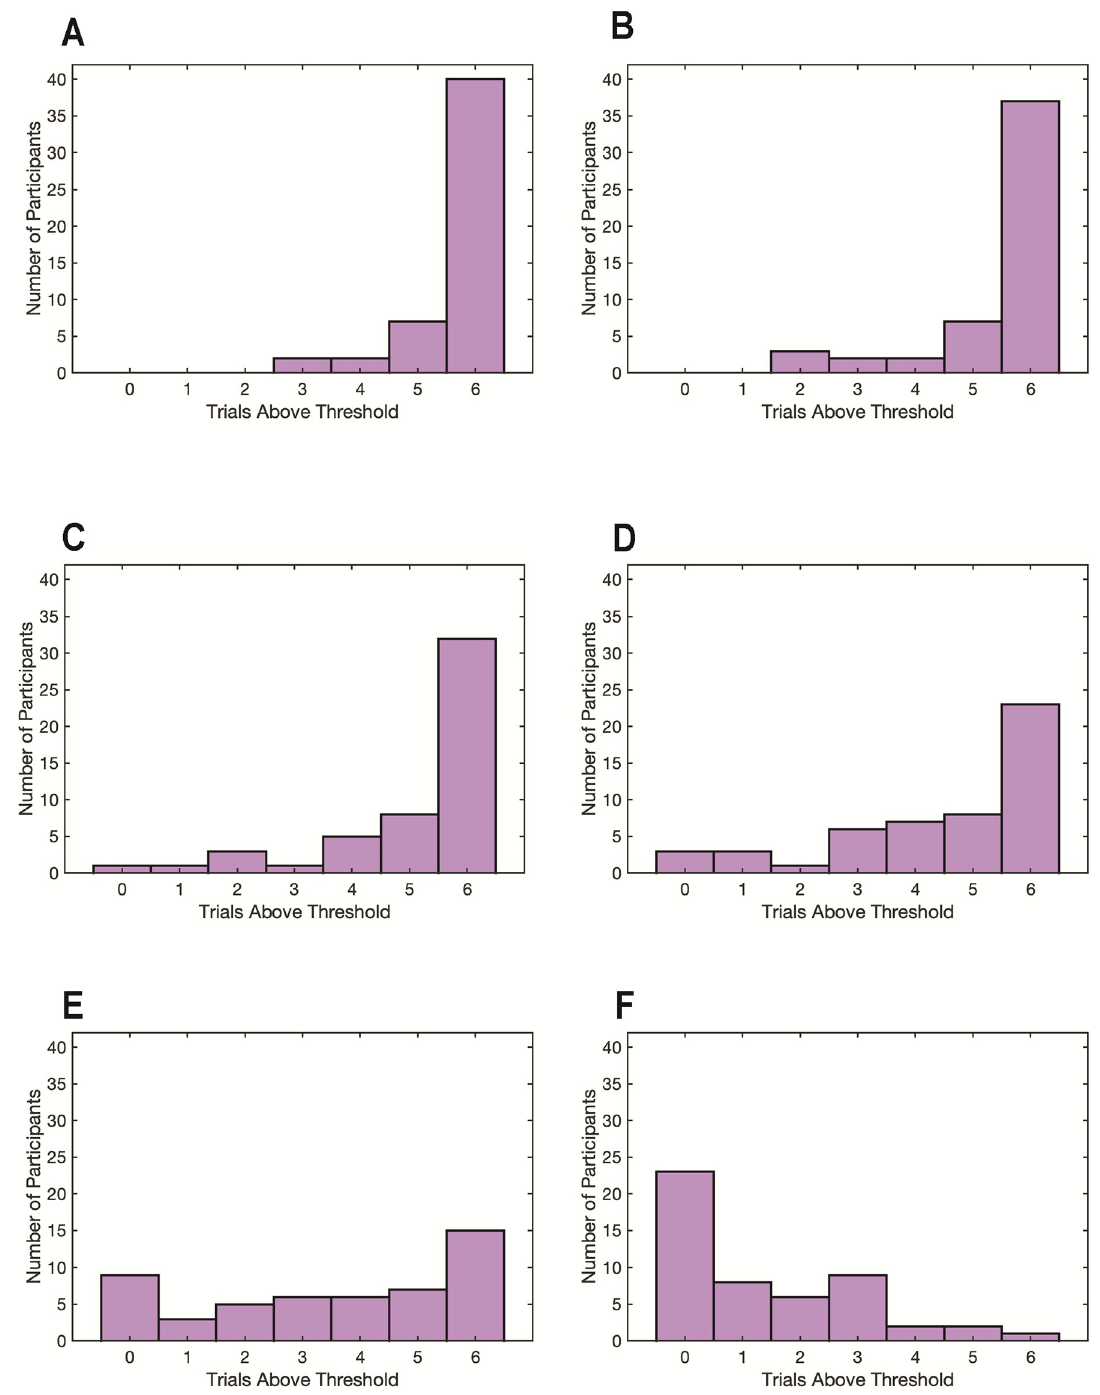
Fig 9. Histograms of different valid data thresholds. The number of participants and number of trials that met or exceeded cutoffs for valid data at 50 (A), 60 (B), 70 (C), 80 (D), 90 (E) and 99 (F) percent thresholds are shown.